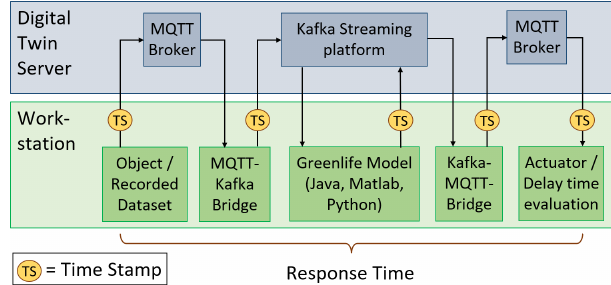
Figure 10. Evaluation of processing delays and response time based on time stamps